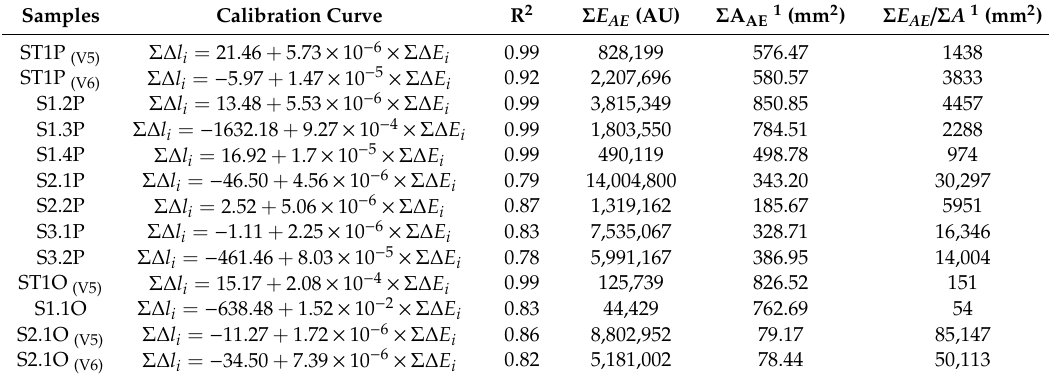
Table 4. BL calibration curves equation to correlate the total emitted E AE with the crack propagation during BL fracture mechanism. The maximum AE energy (A.U.), fractured area (mm 2 ) and the “dynamic surface energy value” (DSV) are also reported.